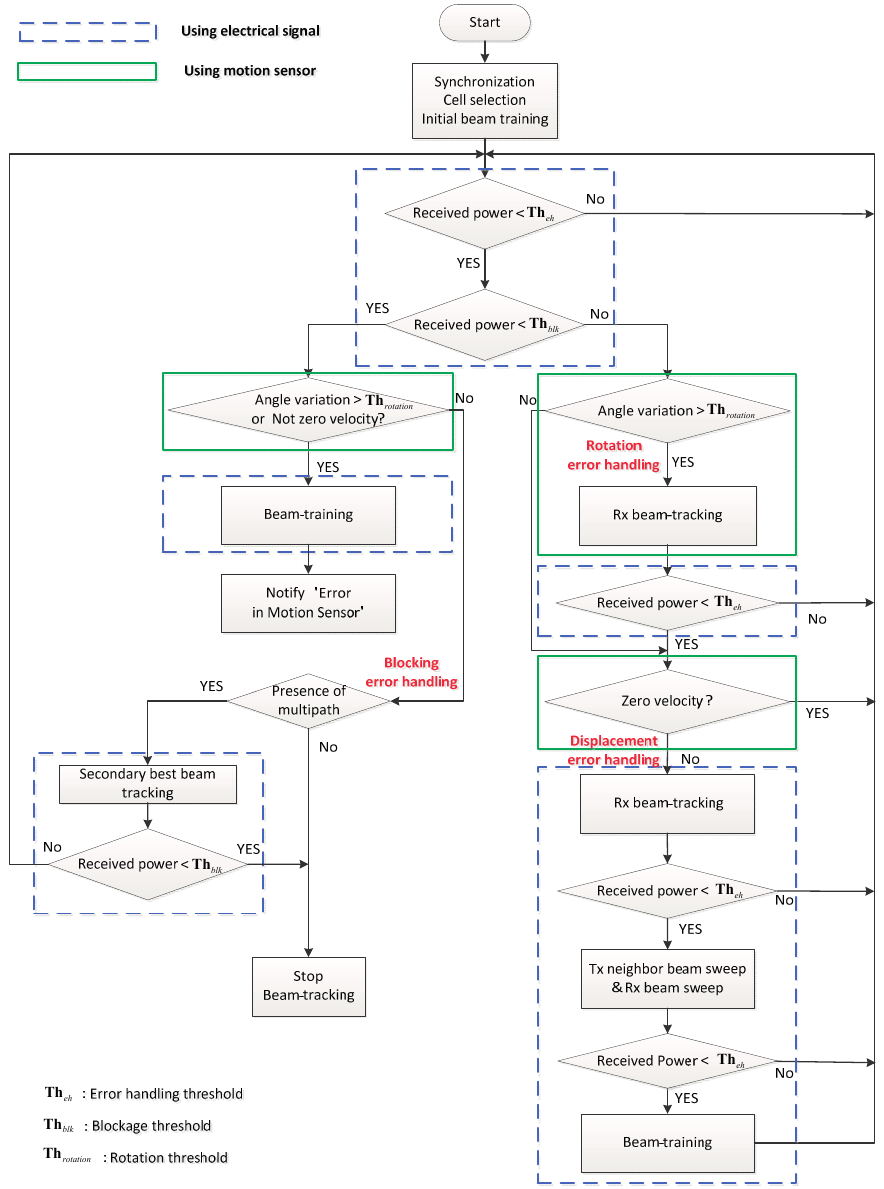
Figure 4. A flowchart of the proposed beam-tracking